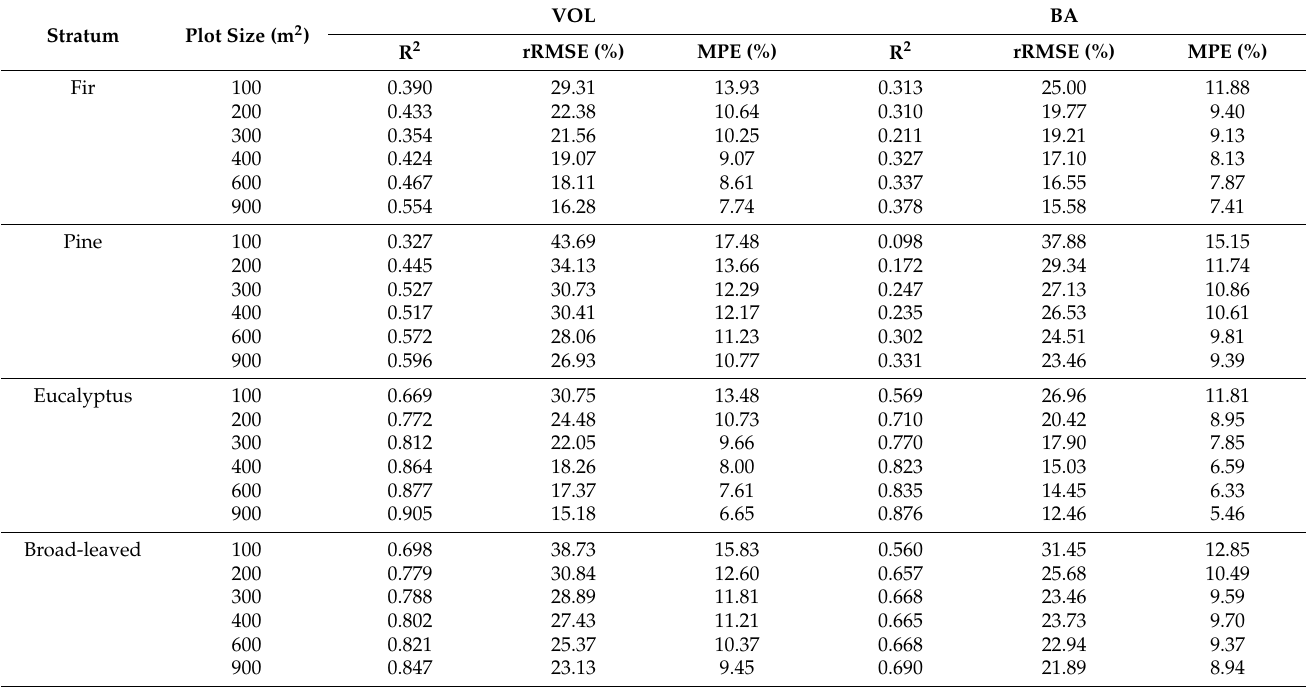
Table 4. Means of R 2 , rRMSE, and MPE for the predictive models of VOL and BA in plots of various sizes in the four datasets of four forest types.